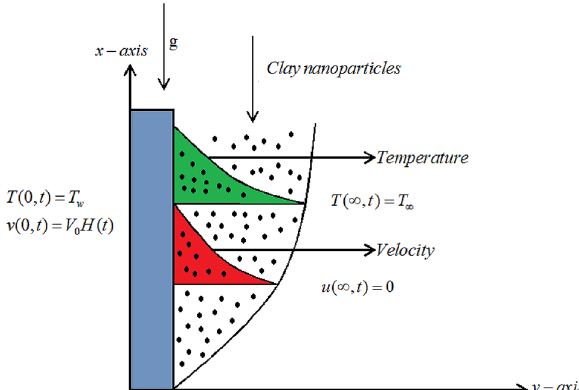
Figure 1. Geometry of the